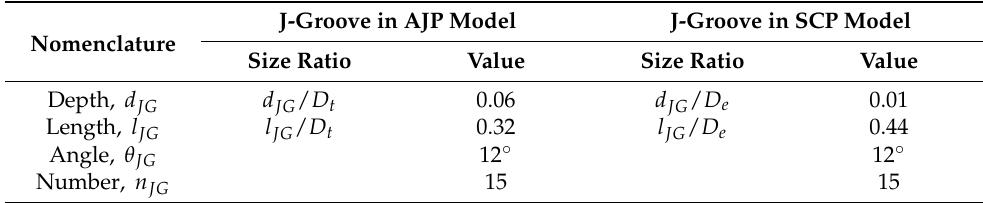
Table 3. Shape parameters of J-Groove for AJP and SCP